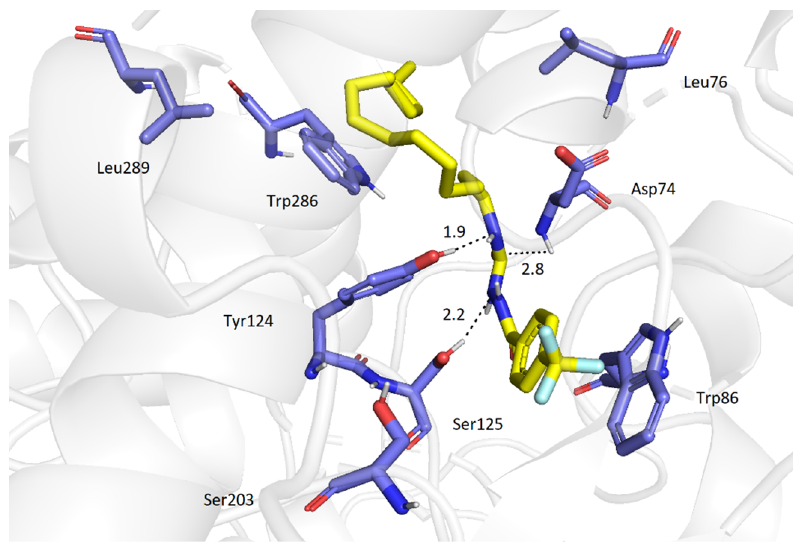
Figure 3. Molecular interactions of 2o (yellow) and AChE.